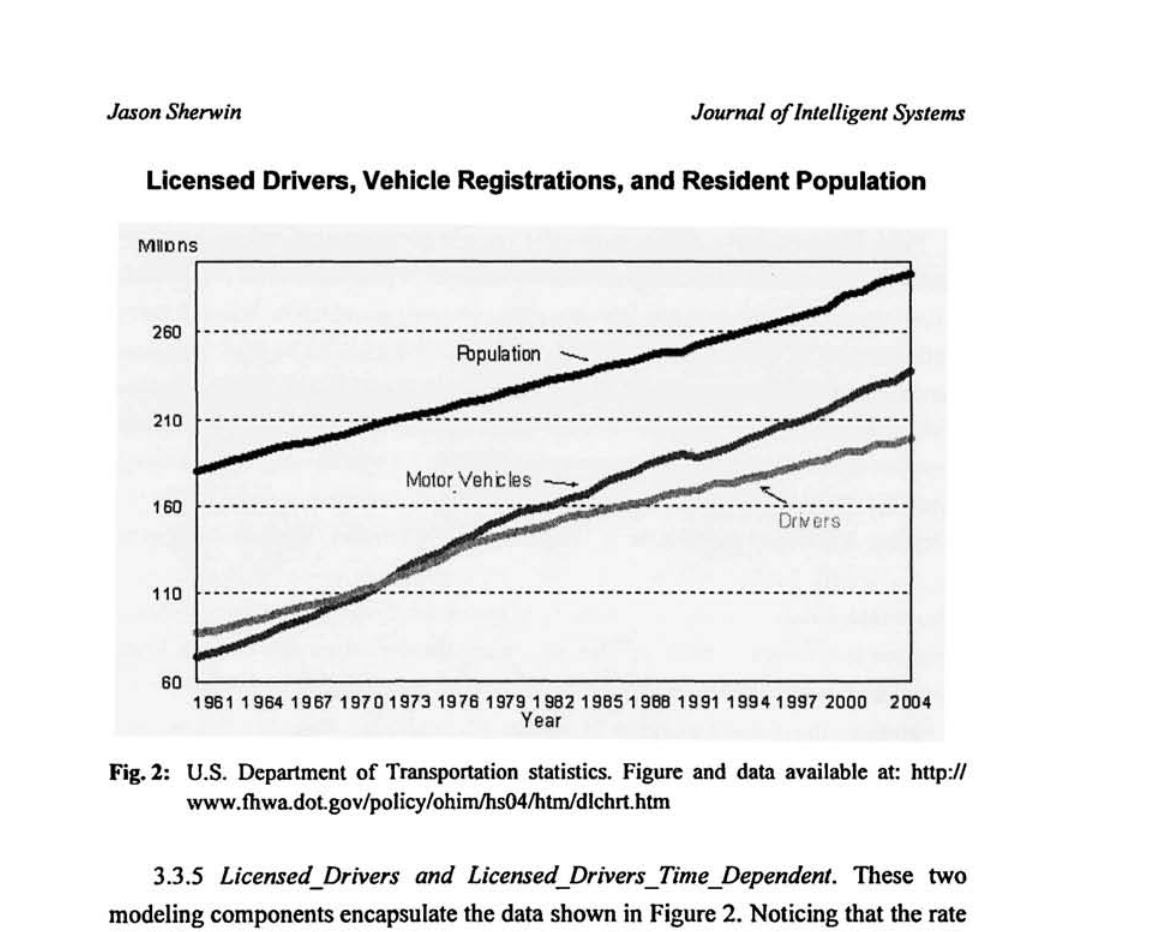
Fig. 2: U.S. Department of Transportation statistics. Figure and data available at: http://